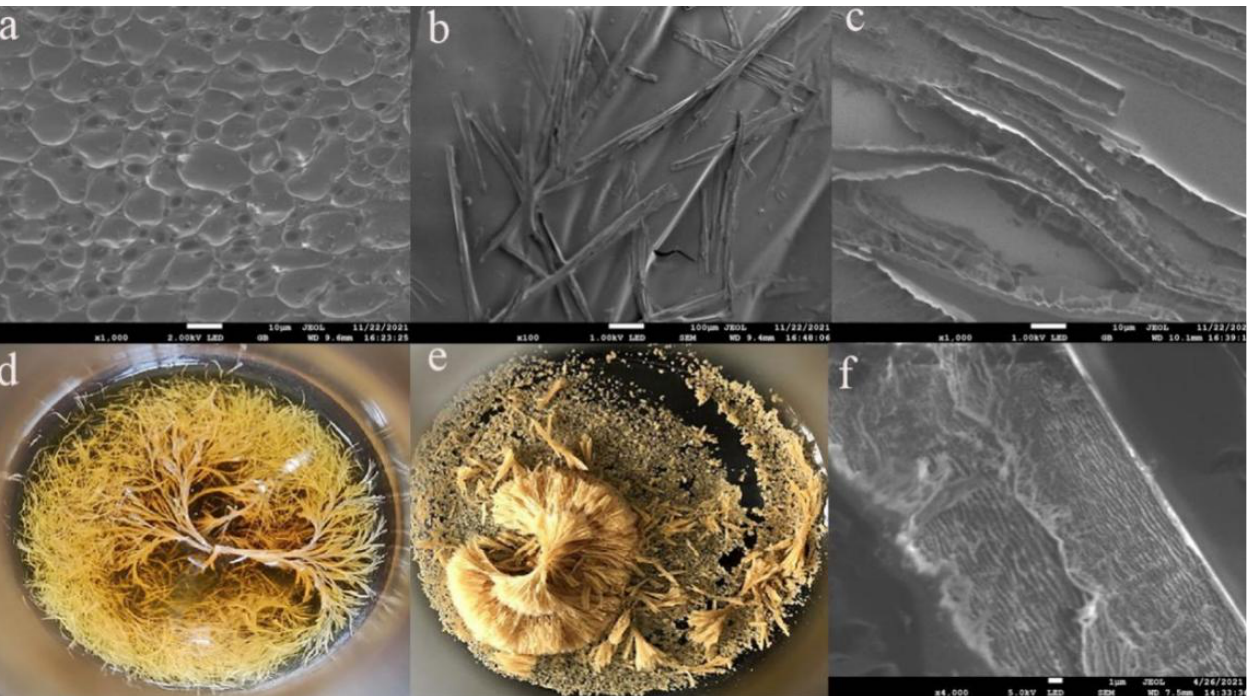
Figure 5. SEM images of dried CMCS/EVA with at 2 × 10 3 ( a ), 2 × 10 4 ( b ) and ( c ) 15 × 10 4 molecular weight, which are stirred in a magnetic mixer at 120 rpm for 15 days; ( d ) EVA precipitated with symmetrical shapes ( e ) dried d and ( f ) regular structure of e.